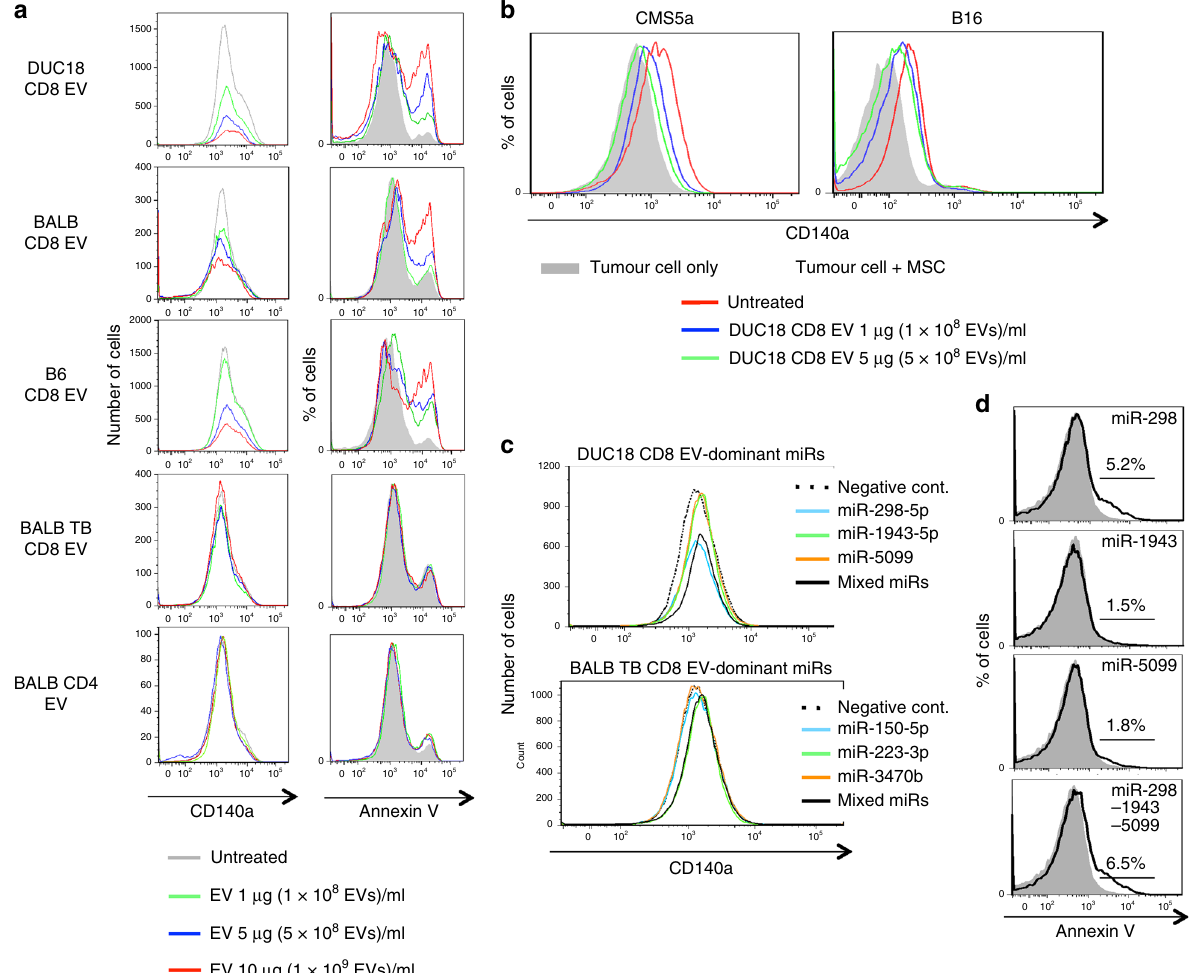
Fig. 2 Reduced viability of cultured MSCs by CD8 + T cell EVs. a DUC18 CD8 EVs, BALB CD8 EVs, B6 CD8 EVs, BALB TB CD8 EVs or BALB CD4 EVs were added to bone-derived MSC cultures at the indicated doses. Three days after EV treatment, bone-derived MSCs ( n = 5 per group) were stained with anti- CD140a mAb and annexin V and subjected to fl ow cytometric analysis. b CMS5a and B16 cells were cultured with bone-derived MSCs for 4 days in the presence of DUC18 CD8 EVs at the indicated doses ( n = 4 per group). The obtained tumour cells were analysed for CD140a expression by fl ow cytometry. c Selected miR-298-5p, -1943-3p and -5099 as both DUC18 CD8 EV- and BALB CD8 EV-dominant miRNAs were synthesised and transfected alone or in a mixture by lipofection into bone-derived MSCs ( n = 4 per group). Synthetic BALB TB CD8 EV-dominant miRNAs (miR-150, 223-3p or 3470b) were used as controls ( n = 4). 3 days after transfection, the obtained bone-derived MSCs were stained with CD140a- and Sca-1-speci fi c mAbs and annexin V ( d ),